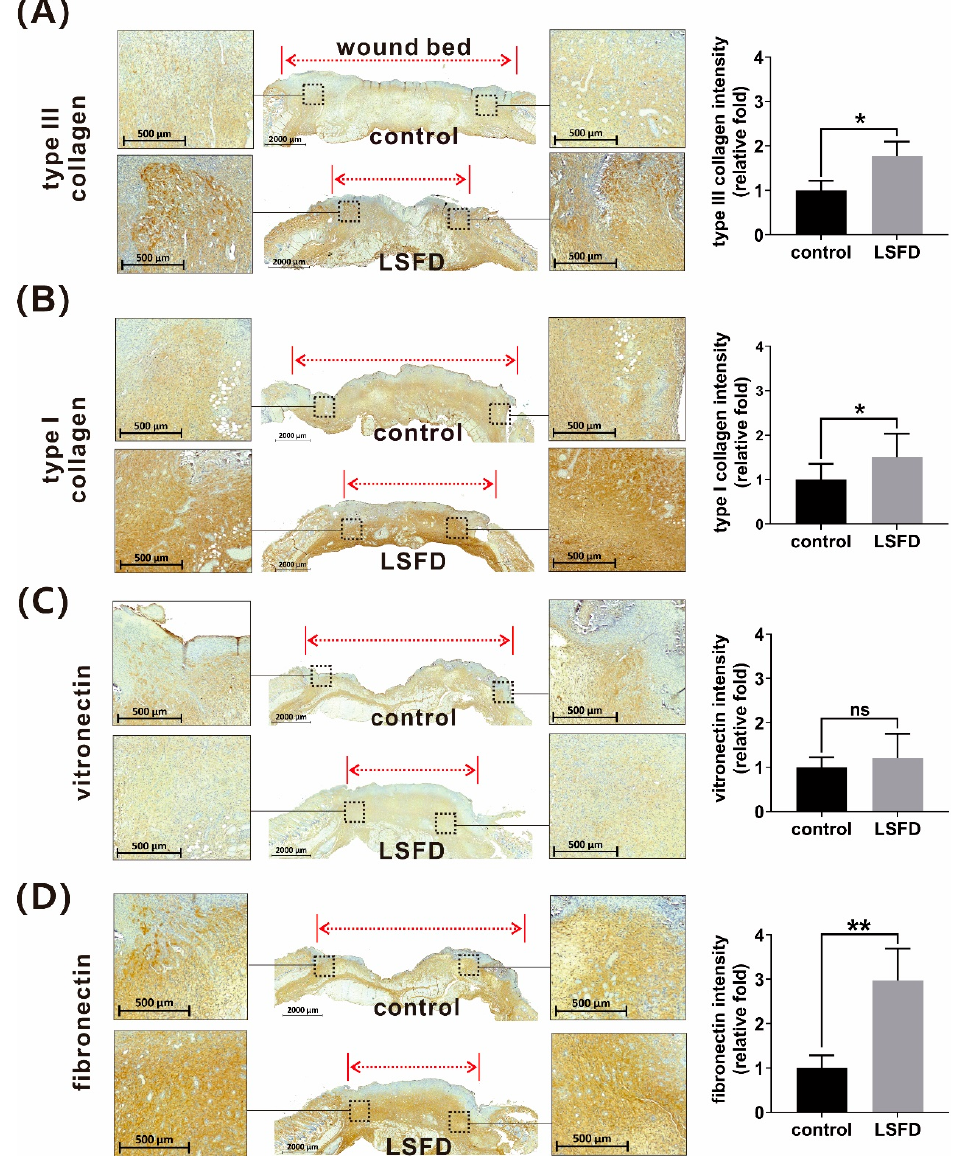
Figure 5. Immunohistochemistry staining and quantitative data of ( A ) type III collagen, ( B ) type I collagen, ( C ) vitronectin, ( D ) fibronectin rat tissue sections of the β -sheet lyophilized silk fibroin dressing (LSFD)-treated group and the control group. All quantitative representations show the relative fold difference in ECM protein expression between the β -sheet LSFD-treated group and the control group. Data are presented as the mean ± standard error of the mean ( n = 6; * p < 0.05, ** p < 0.01, ns: not significant).